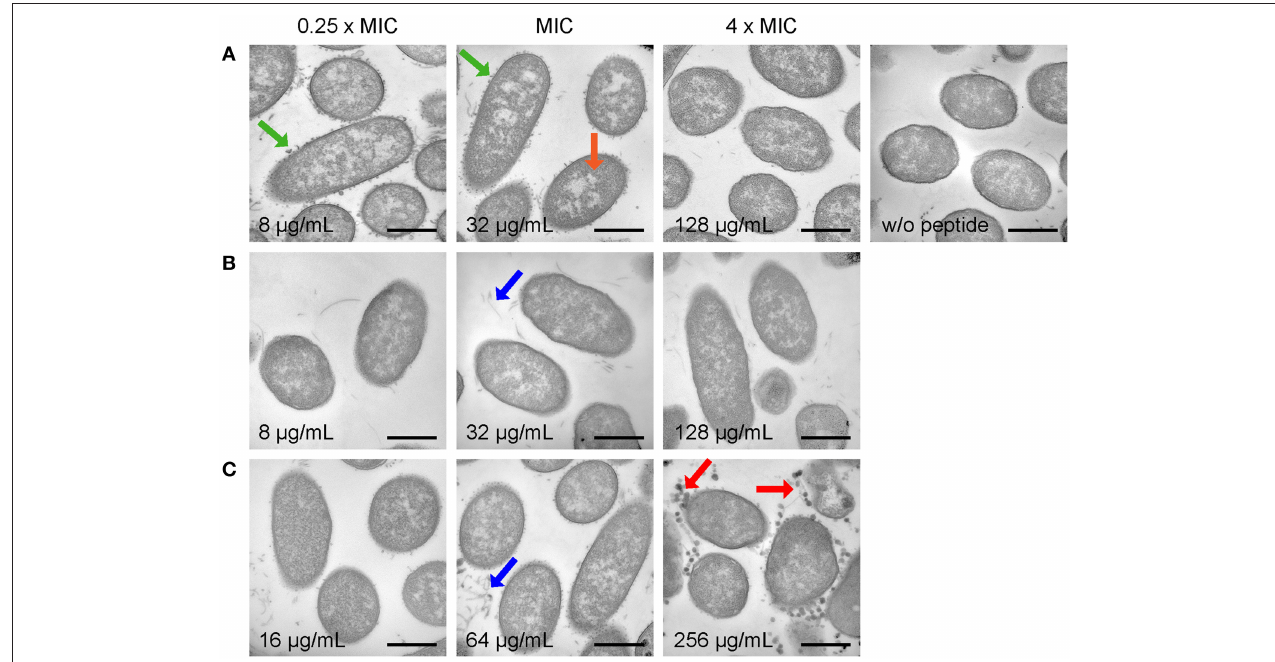
FIGURE 4 | Electron microscopy images of E. coli DSM 1103 incubated with Api137 (A), Api795 (B), and Api794 (C) at concentrations corresponding to 0.25 × MIC, MIC, and 4 × MIC for 1 h using cell densities of 5 × 10 8 CFU/mL. Black bars represent 500 nm. Morphological changes are indicated with arrows: dissociated fragments (blue), small vesicle release (green), large vesicle release (red), and relocalized DNA (orange).